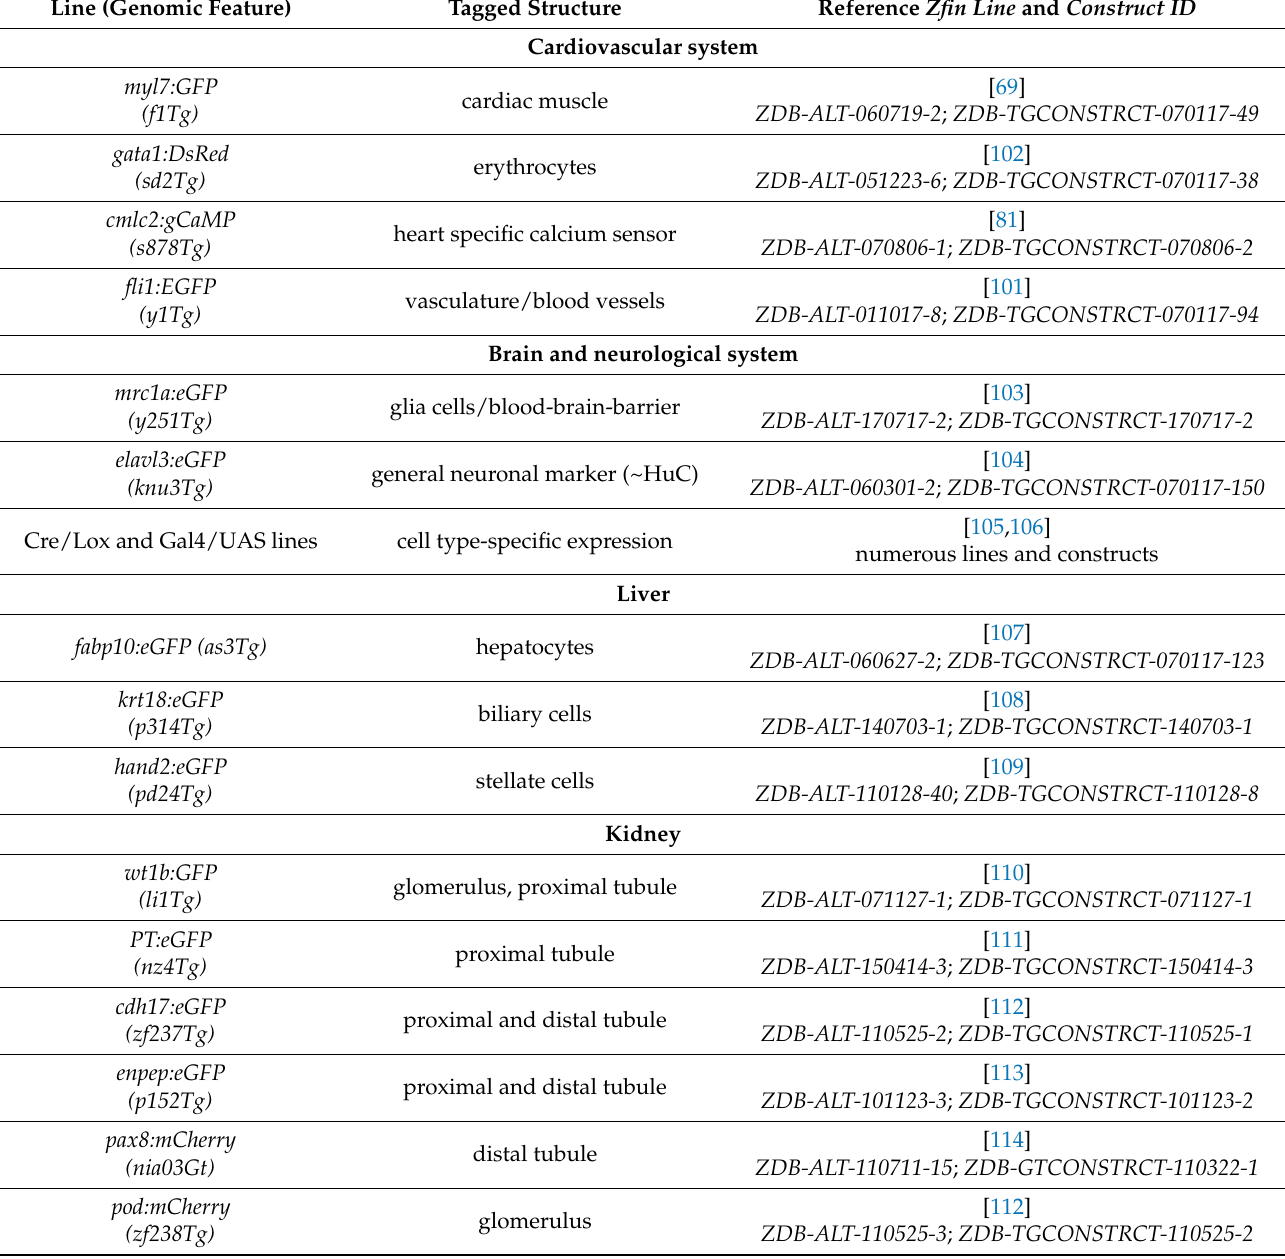
Table 2. Commonly used transgenic lines for cell type-/tissue-specific investigation in